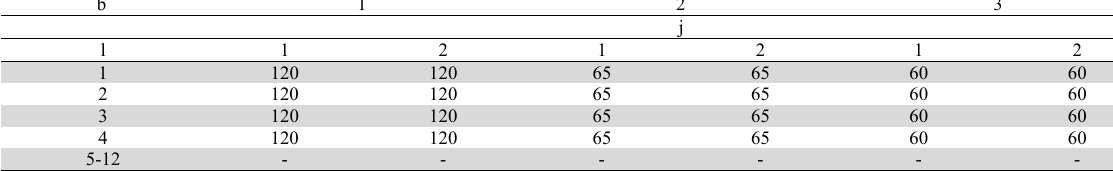
Sales price of final products by direct shipment from plants to retailers(Pr b jl ) (Rial×10 4 )